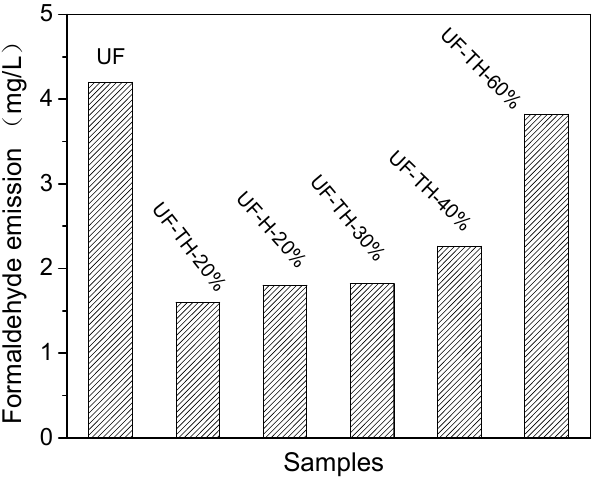
Figure 5. DTA curves of UF and UF/HNTs nanocomposite.